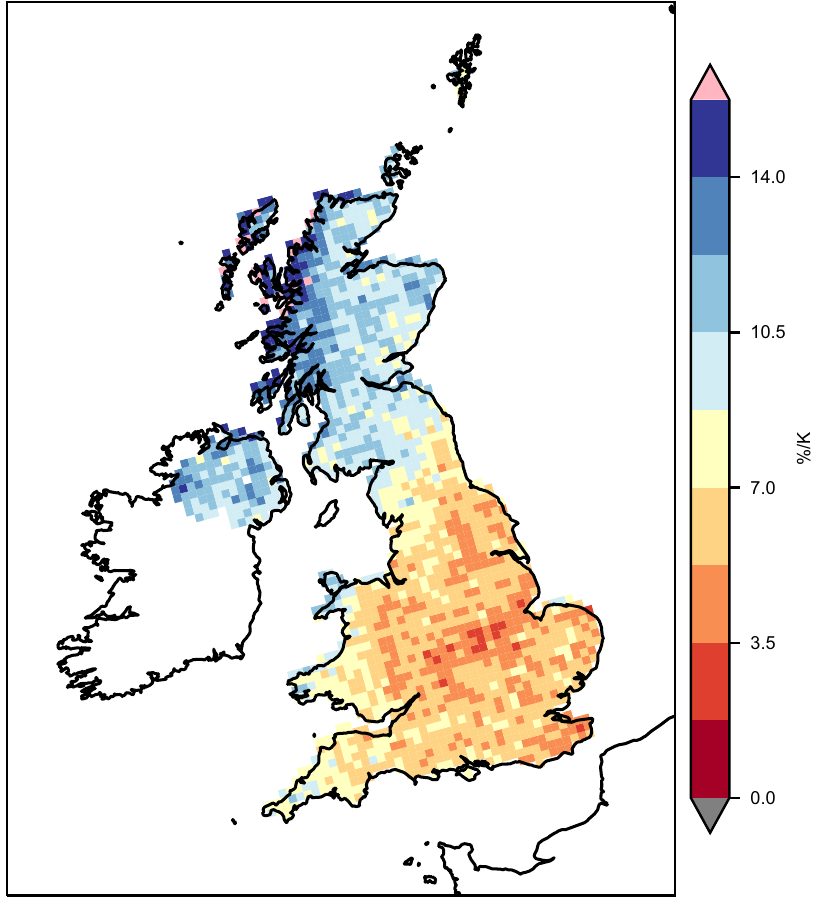
Fig. 7 | Temperature scaling of underlying change in local maximum hourly precipitation. Scaling coef fi cients (%/K) for underlying climate change signal in local annual maximum hourly precipitation in the convection-permitting model (CPM). Values correspond to the gradient of a linear trend line fi tted to smoothed